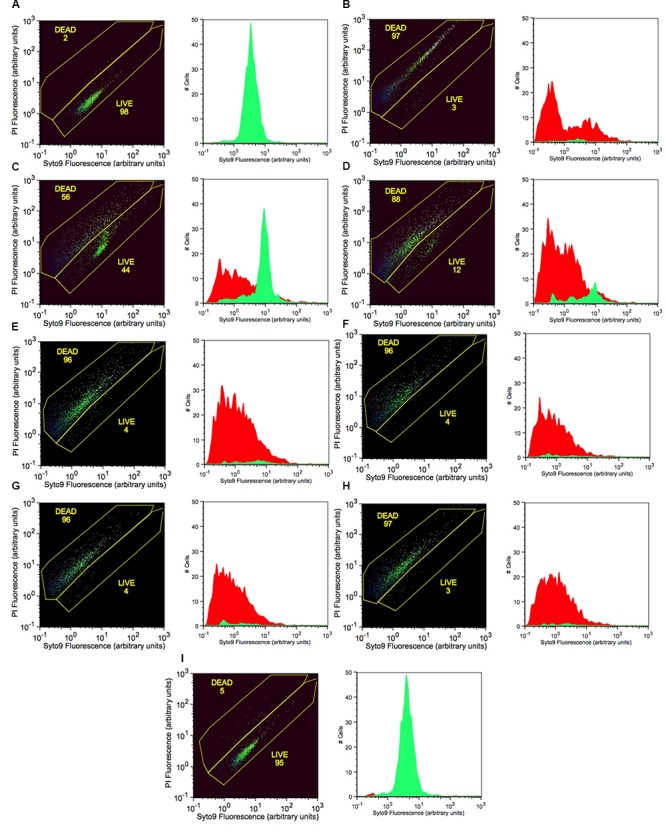
Increasing concentrations of potassium tetraborate tetrahydrate (PTB) increases bacterial membrane permeability to propidium iodide as shown by flow cytometry with Syto9 and PI staining. (A) live cells (non-treated; calibration standard); (B) dead cells (killed with 70% isopropanol; calibration standard). Bacterial cells treated with PTB at increasing millimolar concentrations (C) 50; (D) 60; (E) 70; (F) 80; (G) 90; (H) 100; (I) non-treated bacteria (control). The X-axis indicates the intensity of Syto9 green fluorescence and the Y-axis indicates the intensity of PI red fluorescence (arbitrary units: a). flow cytometry data are represented as the percentage of live and dead cells (black images) with the fluorescence intensity of Syto9 and PI dyes. Graphs show the images present the cell counts of live (green) and dead (red) cells.